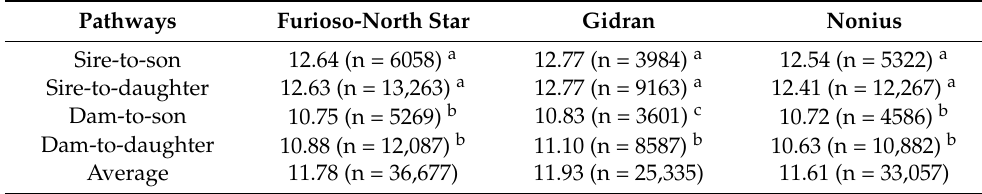
Table 2. Estimated generation intervals for the populations